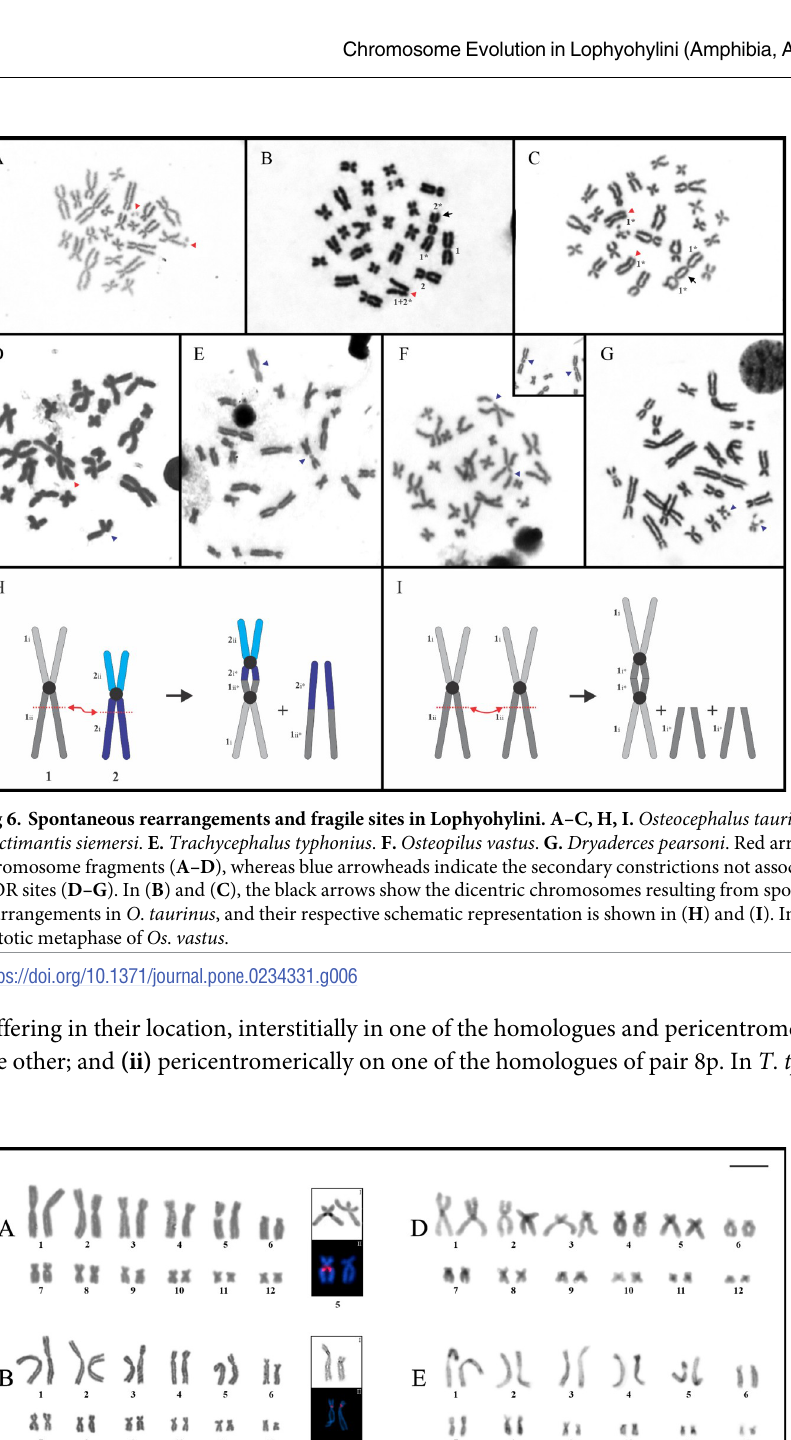
Fig 7. Karyotypes of Nyctimantis . A, D. N . siemersi . B, E. N . rugiceps . C, F. N . arapapa . Conventional staining (left) and C-bands (right). The squares show chromosomes carrying NOR sites: I. Ag-NORs, II. FISH with 18S rDNA.